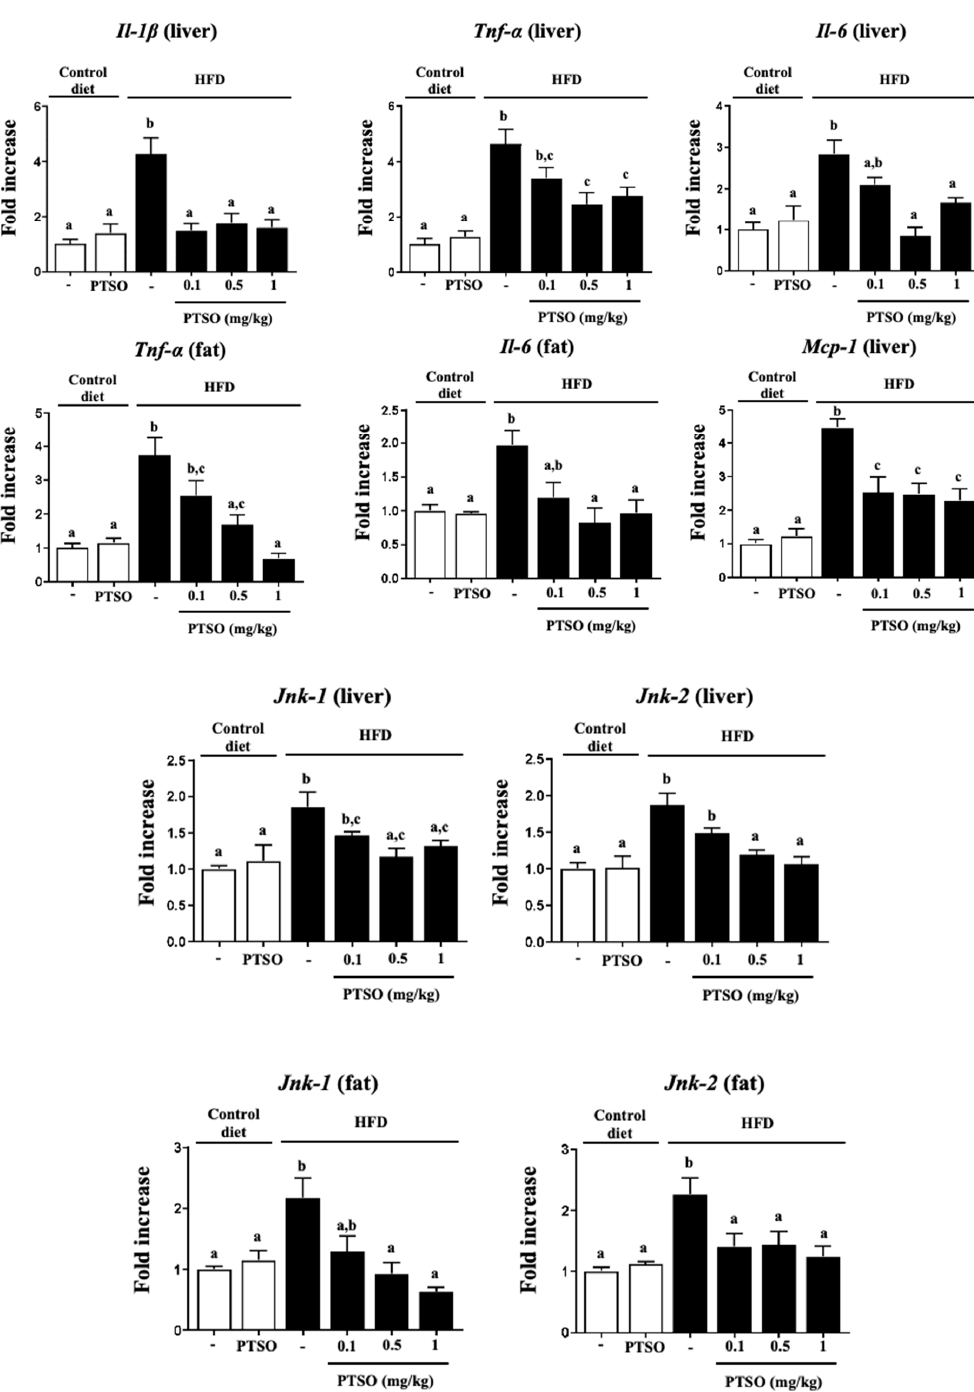
Figure 3. Effects of propyl propane thiosulfonate (PTSO) administration on the liver and fat gene expression of Il-1 β , Tnf- α , Il-6 , Mcp-1 , Jnk-1 and Jnk-2 in control and high-fat diet (HFD)-fed mice, which was analyzed using real-time qPCR. Groups with different letters statistically differed ( p < 0.05).